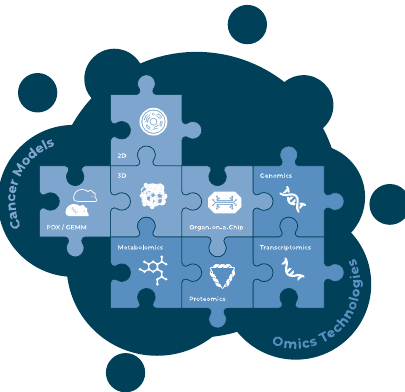
Figure 2. Cancer models and omics technologies to obtain a comprehensive picture of biological processes within a patient`s tumor. An appropriate combination of different omics technologies and relevant tumor models allows a more comprehensive analysis of intra-tumor heterogeneity, relevant to improve patient treatment. (PDX—patient-derived xenograft; GEMM—genetically engineered mouse models; 2D—two-dimensional cell culture; 3D—three-dimensional cell culture).